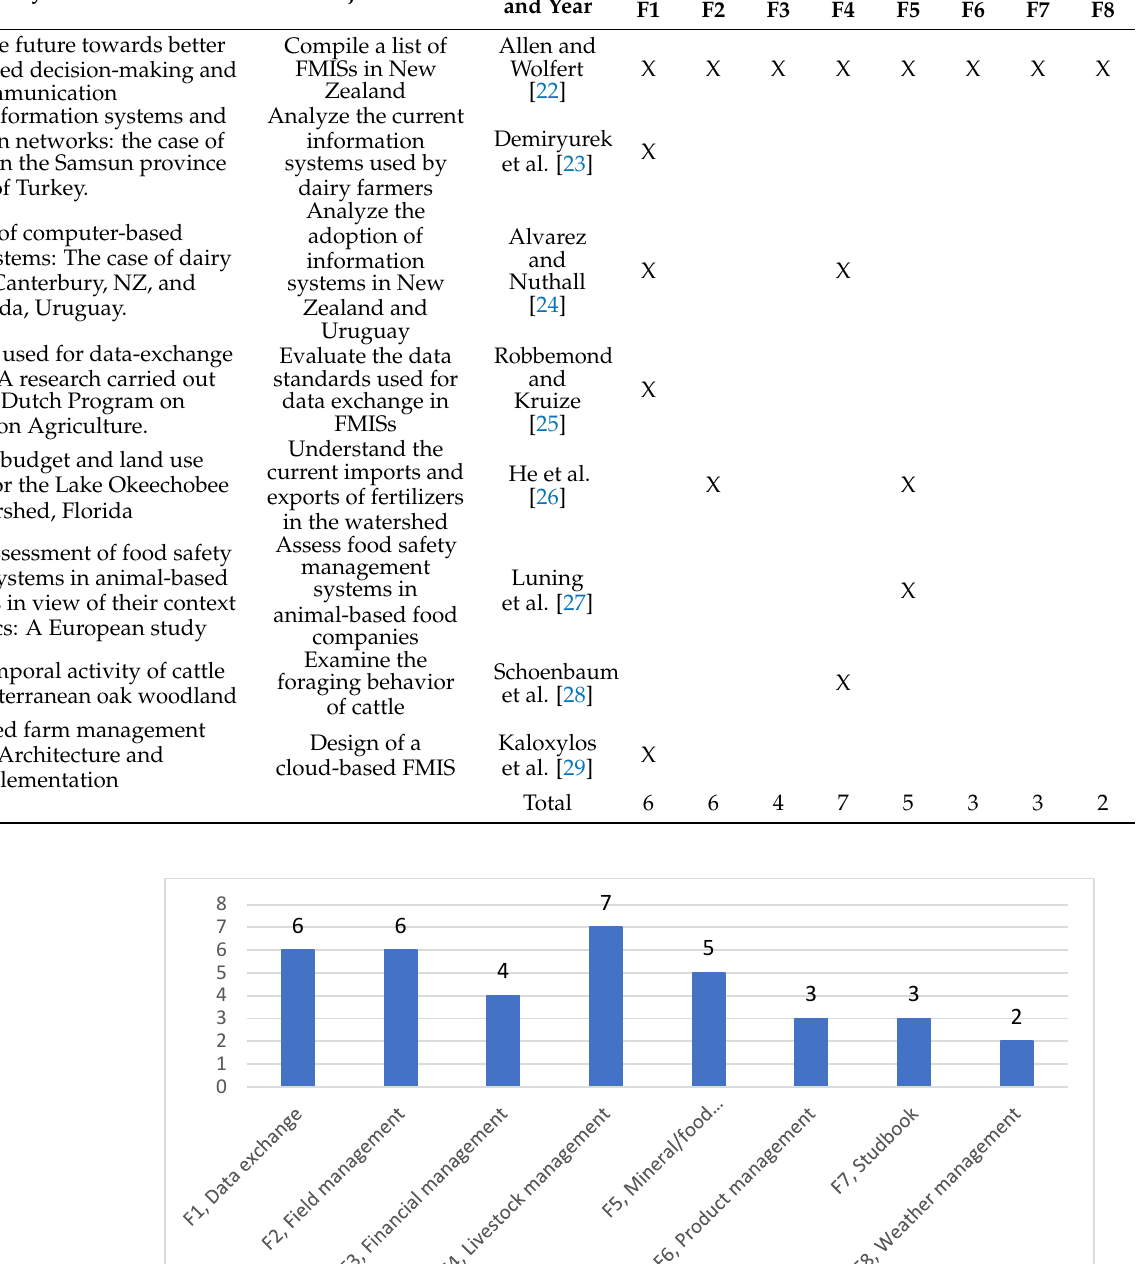
Figure 6. The number of reviewed papers that concern a certain field of focus of an FMIS.